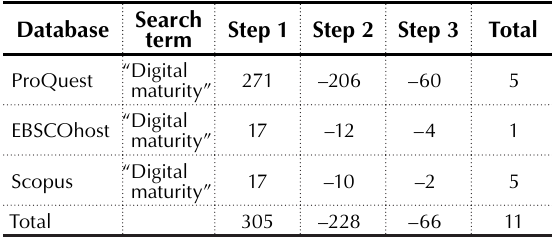
Table 1. Literature search and selection